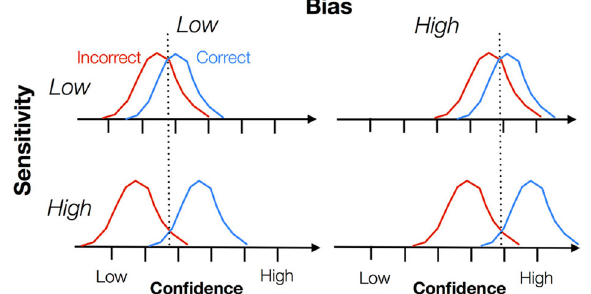
Fig. 3 Four con fi gurations of metacognitive sensitivity and bias levels. The red and blue curves represent the distribution of con fi dence ratings for incorrect and correct trials, respectively. A larger distance between the two curves denotes higher sensitivity. Displacement to the left and right denote biases towards low con fi dence (low metacognitive bias) and high con fi dence (high metacognitive bias), respectively (retrieved from Fig. 1 in Fleming and Lau 46 ). We repeat the disclaimer of the original authors that this fi gure is not a statistically accurate description of correct and incorrect responses, which are typically not normally distributed 46,47 .